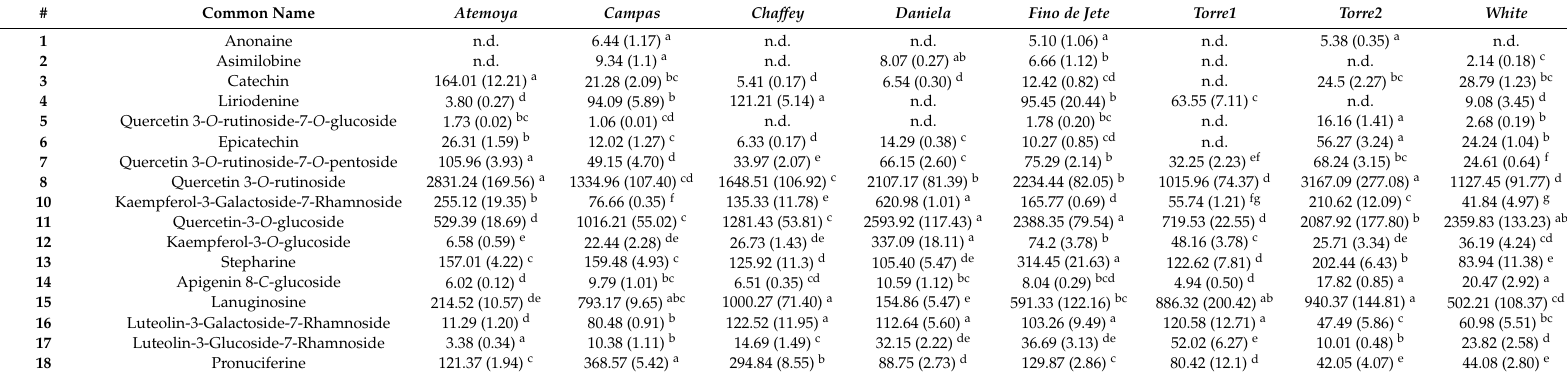
Table 2. Phenolic and alkaloid compounds identified and quantified (mg per 100 g of d.wt material) in the seven extracts of Cherimoya and Atemoya leaves by HPLC-DAD-MS / MS. Values are expressed as mean ( ±